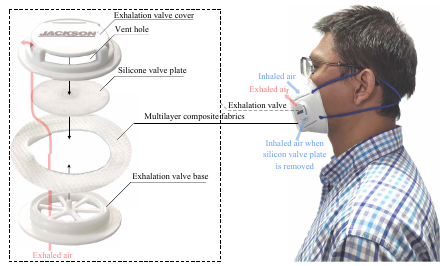
Figure 1. The structure of a KN95 mask with exhalation valve.